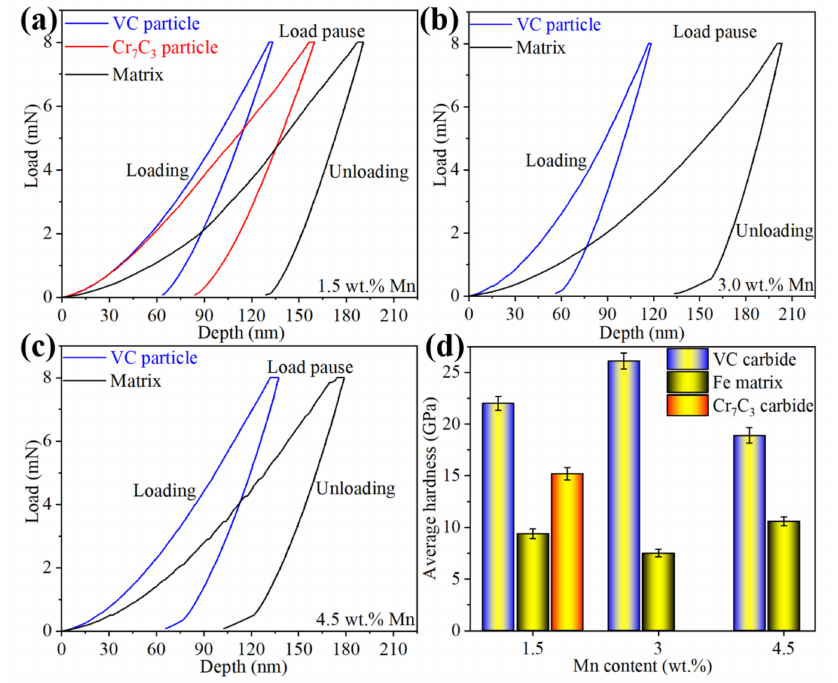
Figure 7. Load-displacement curves ( a – c ) and nano hardness responses ( d ) of three samples with different local